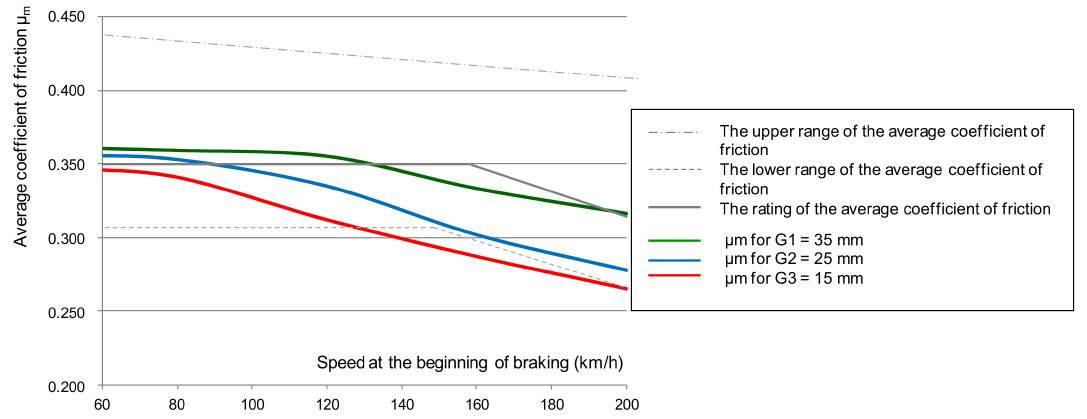
Figure 7. Dependence of the average coefficient of friction µ m on the set braking start speed at N = 25 kN and M = 5.7 t at different friction lining